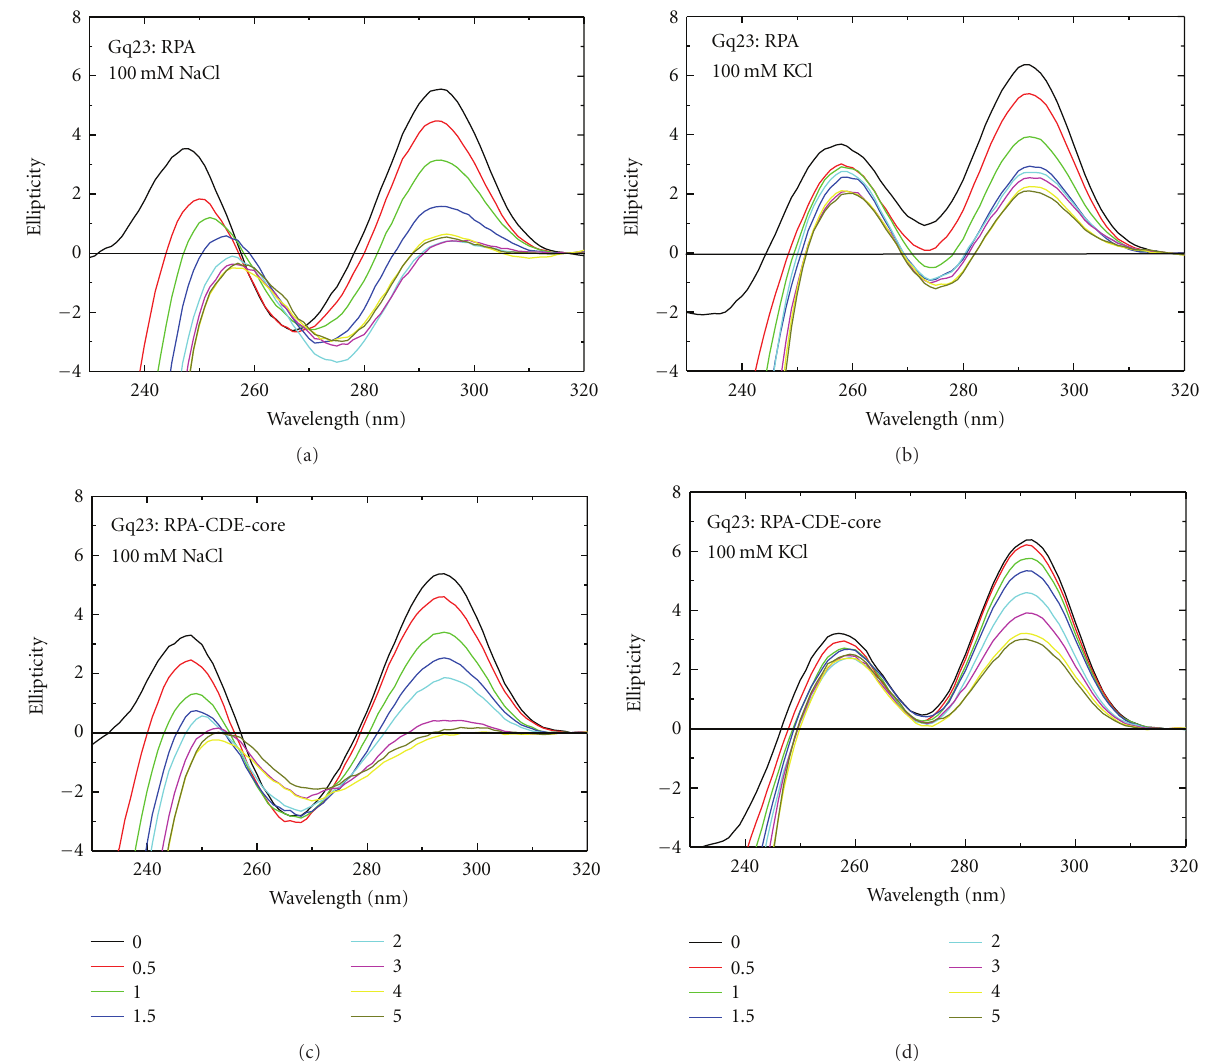
Figure 4: E ff ect of addition of RPA and RPA-CDE-core on Gq23 in the presence of Na + or K + ions. Addition of increasing molar ratios of RPA to Gq23 at (a) 100mMNaCl and (b) 100mMKCl. Addition of increasing molar ratios of RPA-CDE-core to Gq23 at (c) 100mMNaCl and (d)